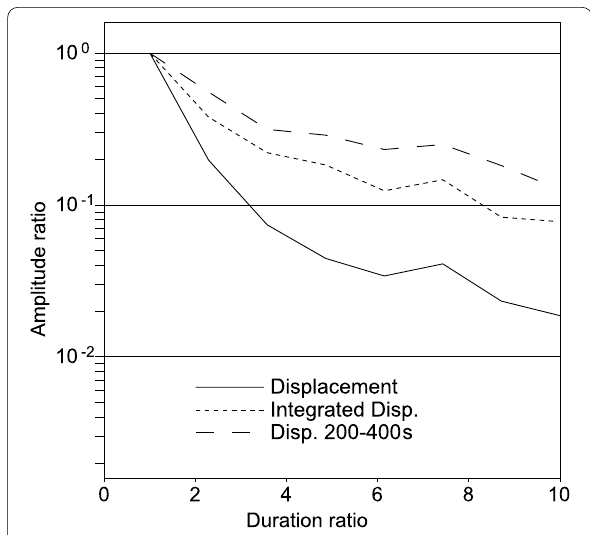
Fig. 9 Amplitude ratio of synthetic records between that for the original finite fault model (U. S. Geological Survey 2020) and that with a time-stretched source time function of f ( t / r t )/ r t , where t denotes time, f ( t ) the original source time function, and r t temporal stretching ratio (shown on the horizontal axis). The amplitude was evaluated at Urahoro station for the 2003 Tokachi-oki earthquake. Three types of amplitudes are shown, highpass filtered displacement (200-s cutoff, solid line); highpass filtered integrated displacement (200-s cutoff, dashed line); bandpass-filtered displacement (200-400 s, long-dashed